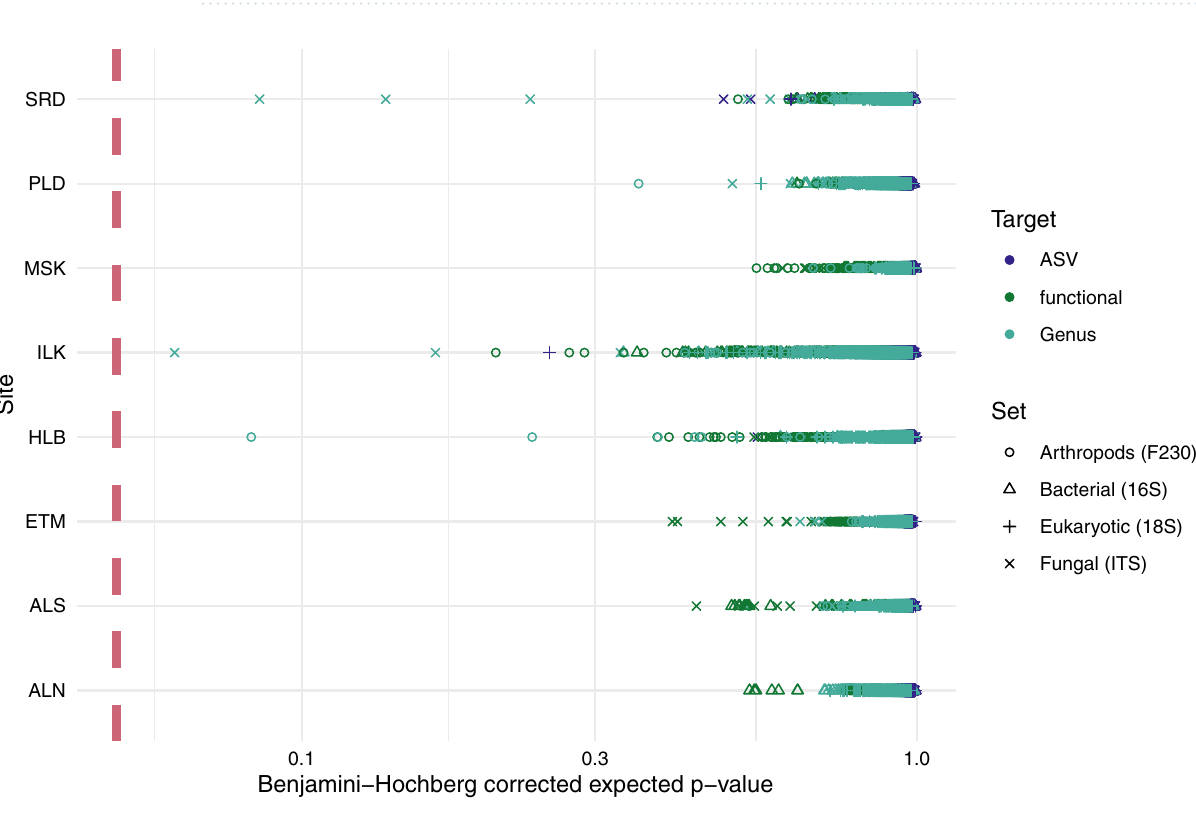
Figure 6. Benjamini–Hochberg corrected significance of pairwise ALDex2 from each control-treatment pairing for each site and metabarcoding target in the study at three levels of organization. Significance ( p < 0.05) is shown on the graph as a light coloured dashed line. Colour and shape are used to differentiate the targeted sequence (Arthropods (F230) , Bacterial (16S) , Eukaryotic (18S) , Fungal (ITS) ) and grouping level (functional , Genus and ASV ). used for each